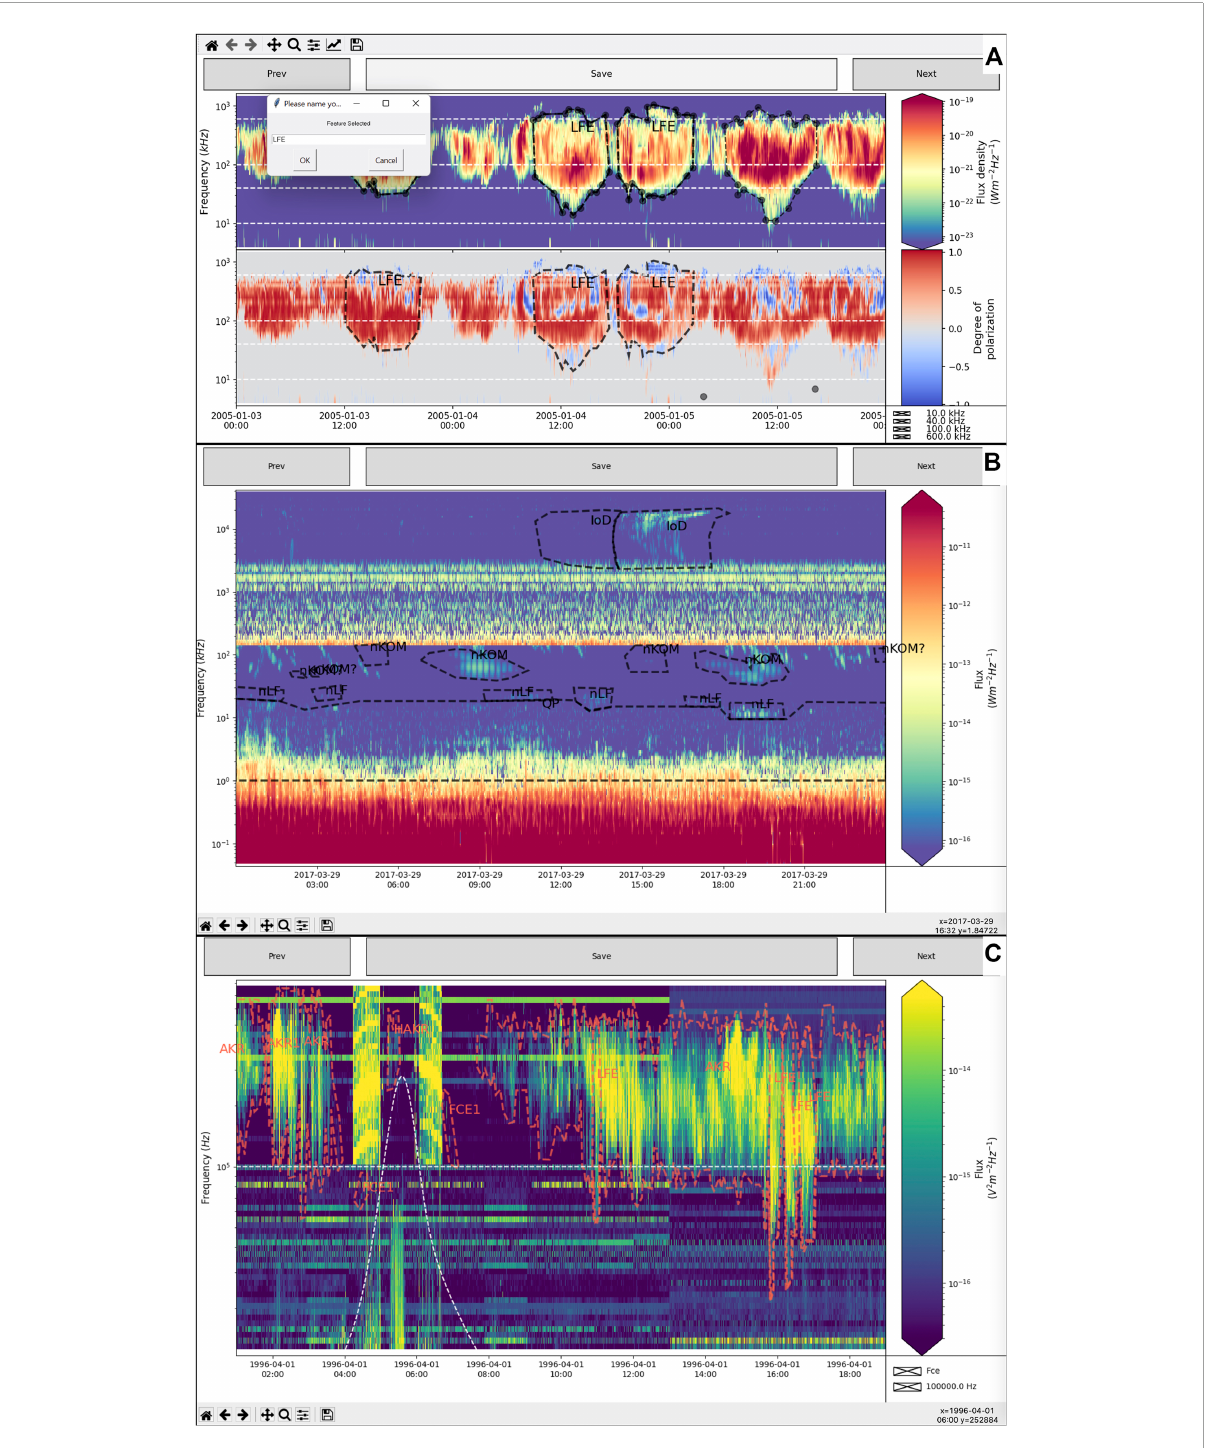
FIGURE 1 Examples of plots from the SPACE labelling Tool. Panel (A) displays Cassini/RPWS (Radio and Plasma Waves Science Gurnett et al., 2004) data (Lamy et al., 2008, 2009). The two panels show Intensity and Polarization data, respectively. At the top right of the top panel one can see a polygon that has just been drawn, with the window for naming the feature appearing at the top left of the graphics window. Other features have already been labelled, and appear in both intensity and polarisation views, with their names overlaid. The data displays in panel (B) are the estimated flux density (Louis et al., 2021a,c) from Juno/Waves measurements (Kurth et al., 2017), with the Louis et al. (2021b) catalogue overlaid. Panel (C) displays observations of Polar/PWI instrument (Gurnett et al., 1995) with the Smith et al. (2022) catalogue overlaid. The horizontal dashed-white line shows an example of the use of the -g [FREQUENCY GUIDE [FREQUENCY GUIDE ...]] option. The variable dashed-white line show that the tool is also able to read a 1D table from the CDF file (provided that this has been specified in the configuration